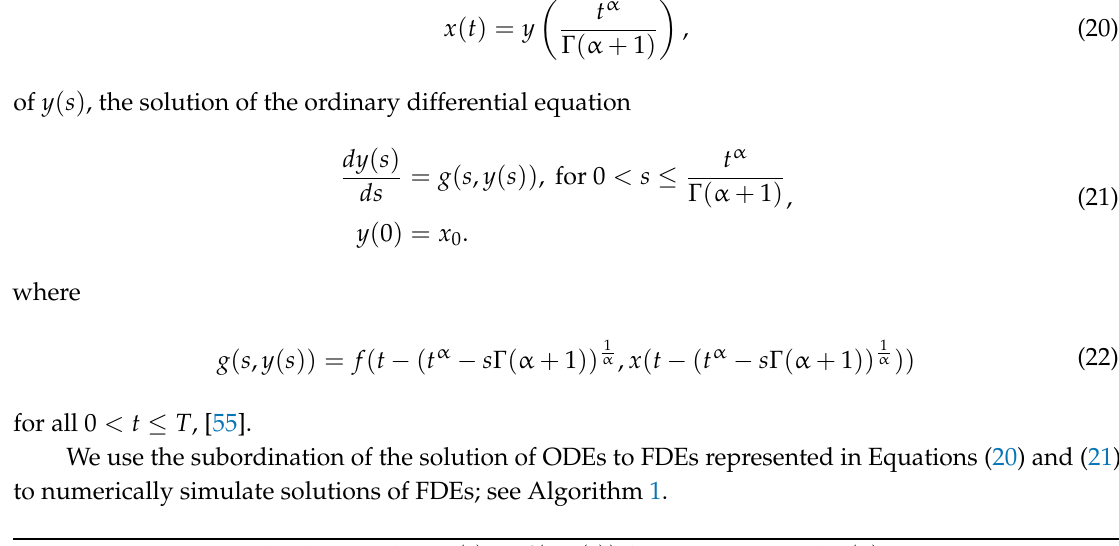
Algorithm 1 Numerical solution of D α ∗ x ( t ) = f ( t , x ( t )) for 0 < t < T with x ( 0 ) = x 0